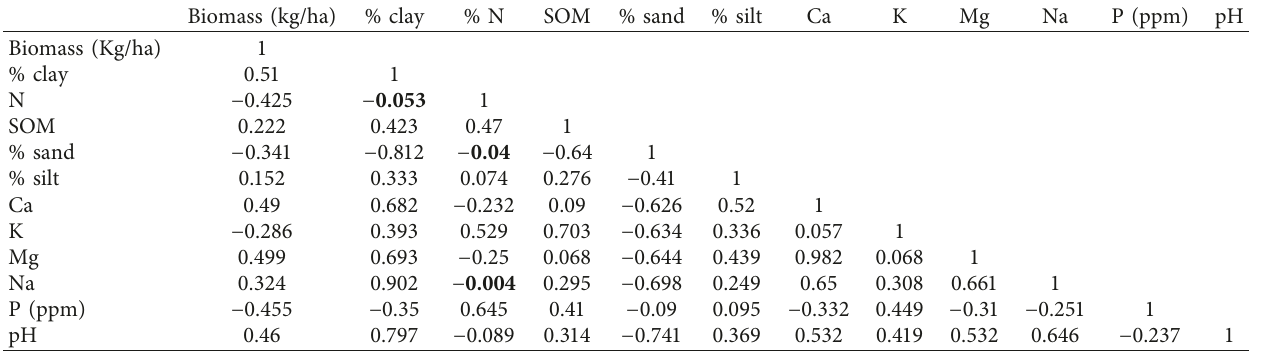
Table 5: Effects of land cover type on physical and chemical soil properties at 0–15cm depth.